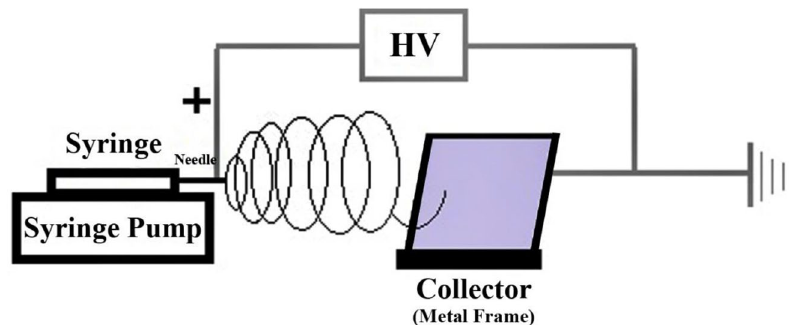
Figure 4. Schematic diagram of the electrospinning